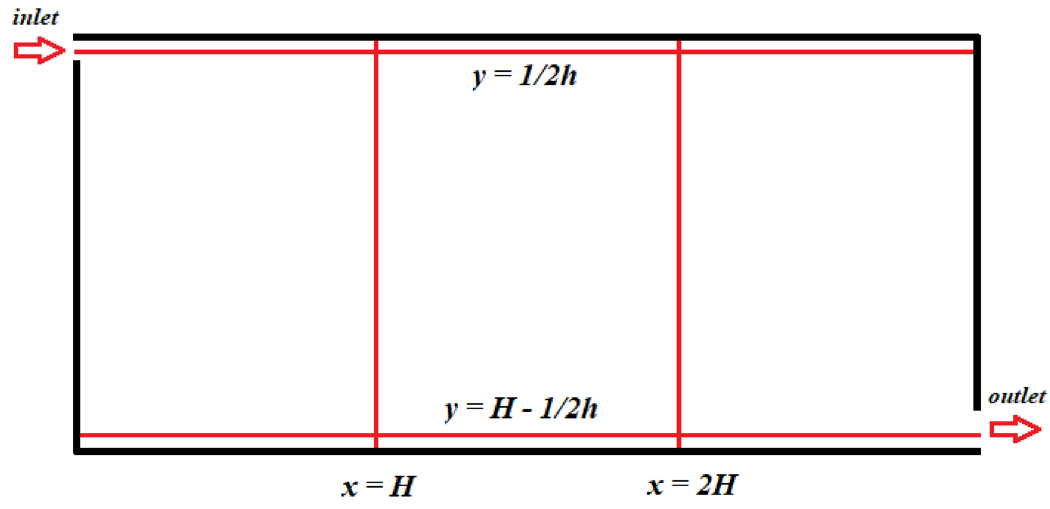
Figure 2. Measuring lines in the central section, z =